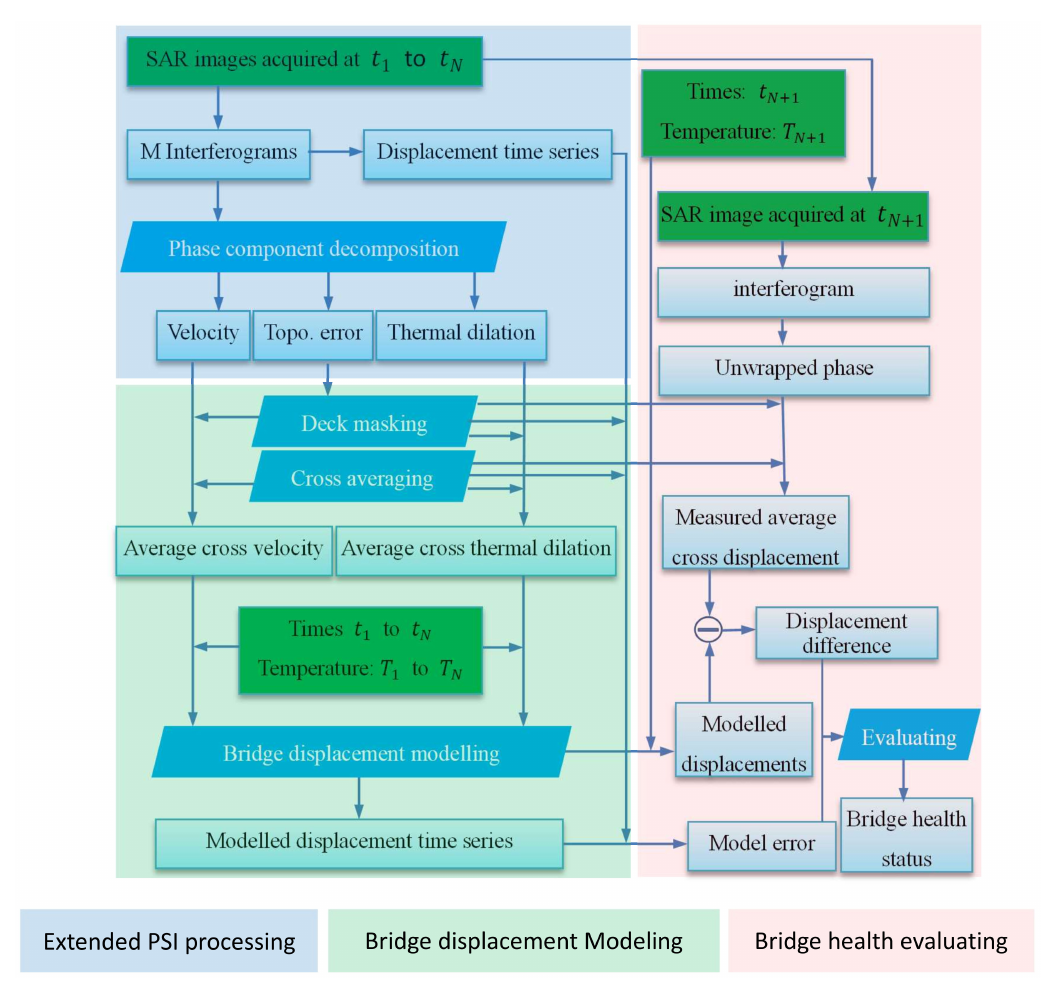
Figure 1. Flow chart of the bridge health evaluation